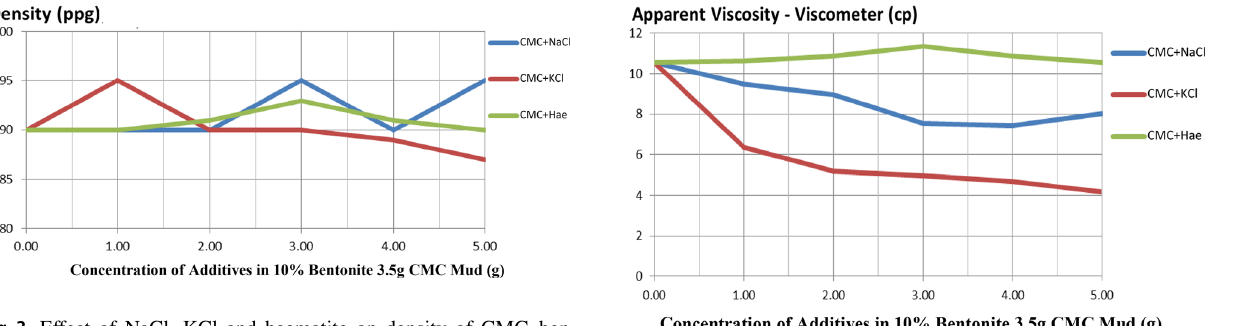
Fig. 3 Effect of NaCl, KCl and haematite on density of CMC–ben- tonite mud